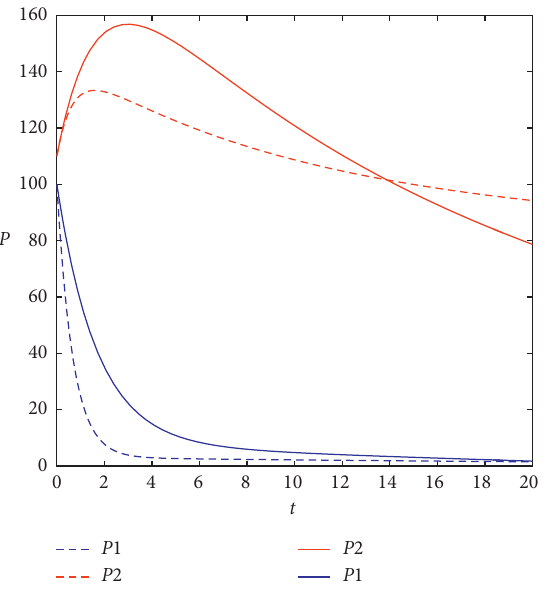
Figure 8: Comparison between two kinds of compensation in pollution